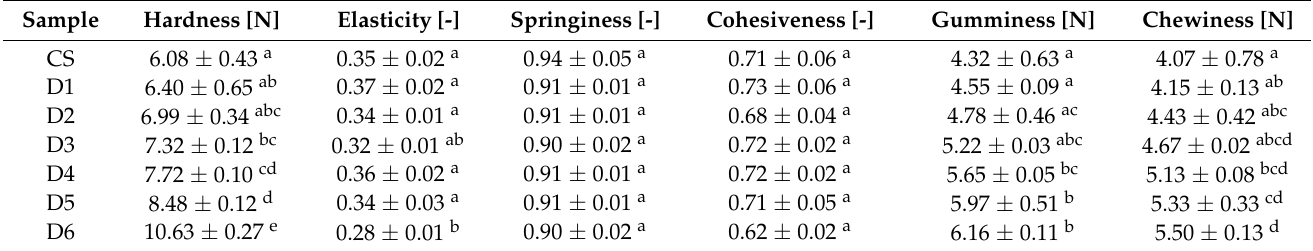
Table 4. Texture of control and DF-enriched bread